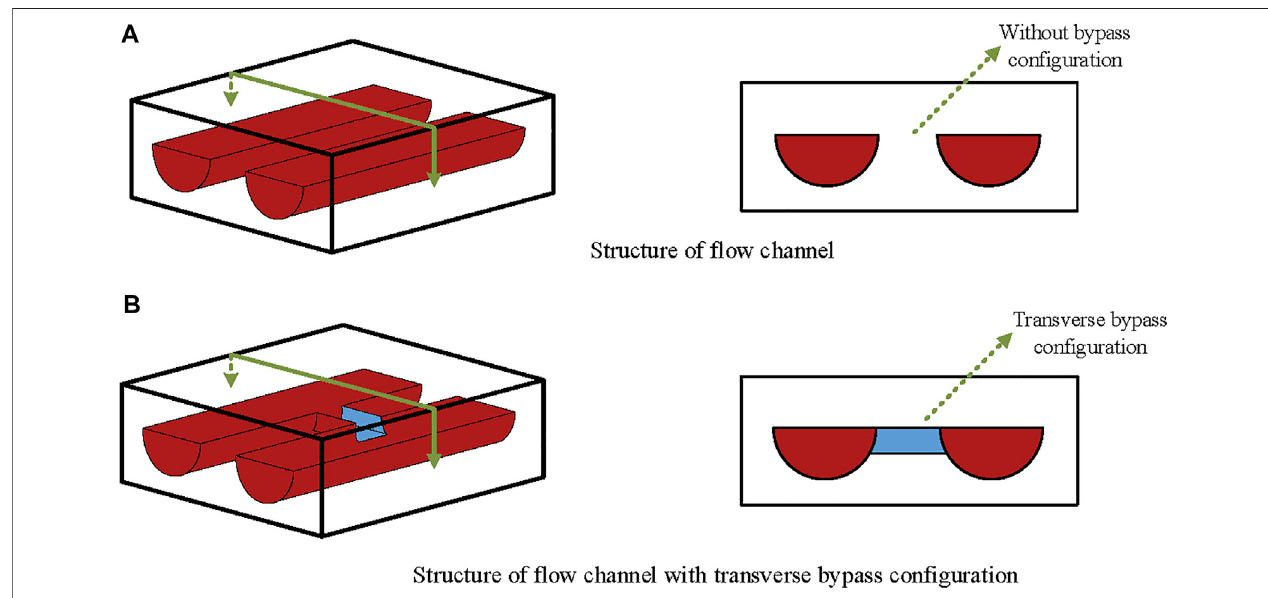
FIGURE14| Structureoftransversebypasscon fi guration. (A) Structureofthe fl owchannel. (B) Structureofthe fl owchannelwithtransversebypasscon fi guration.